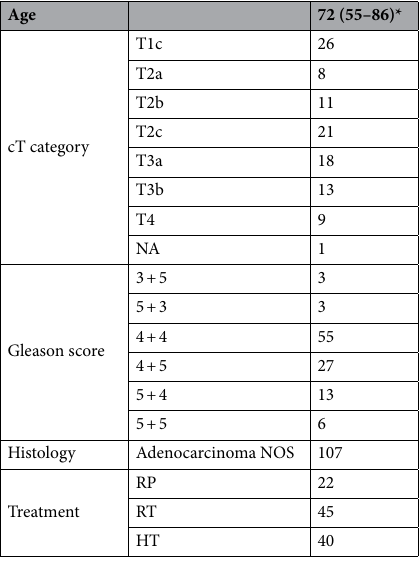
Table 4. Baseline characteristics of the samples from the clinical cohort. *Age is shown as the median (range). All other data represent the number of patients. cT: clinical T; NA: not available; NOS: not otherwise specified; RP: radical prostatectomy; RT: radiation therapy; HT: hormonal therapy.